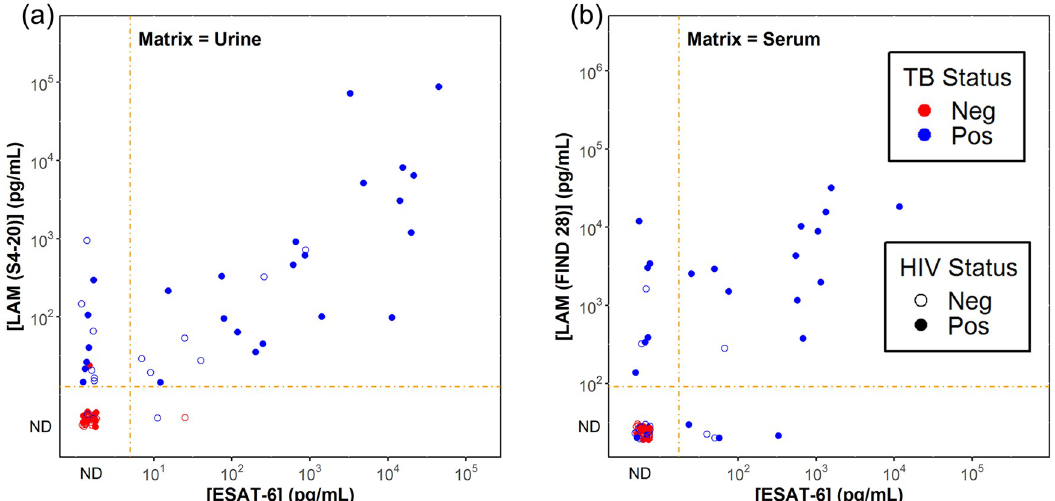
Fig 4. Correlation of LAM and ESAT-6 concentrations. The two plots compare the LAM and ESAT-6 concentrations in urine (panel a) and serum (panel b). The plots display the LAM concentration measured with the most sensitive LAM capture antibody for each matrix: S4-20 for urine and FIND 28 for serum. Concentrations in serum are corrected for the additional 4-fold dilution of serum samples relative to urine samples. The dashed orange lines show the dilution-corrected detection limits for the assays. Data points with signals below the detection thresholds (categorized as “ND” or not detectable) are shown for completeness, but do not have assigned concentrations (see, the discussion in the Fig 3 legend). Percentages of categorical agreement are shown in S5 Table. Data points are colored based on TB status and filled based on HIV status as indicated in the key.